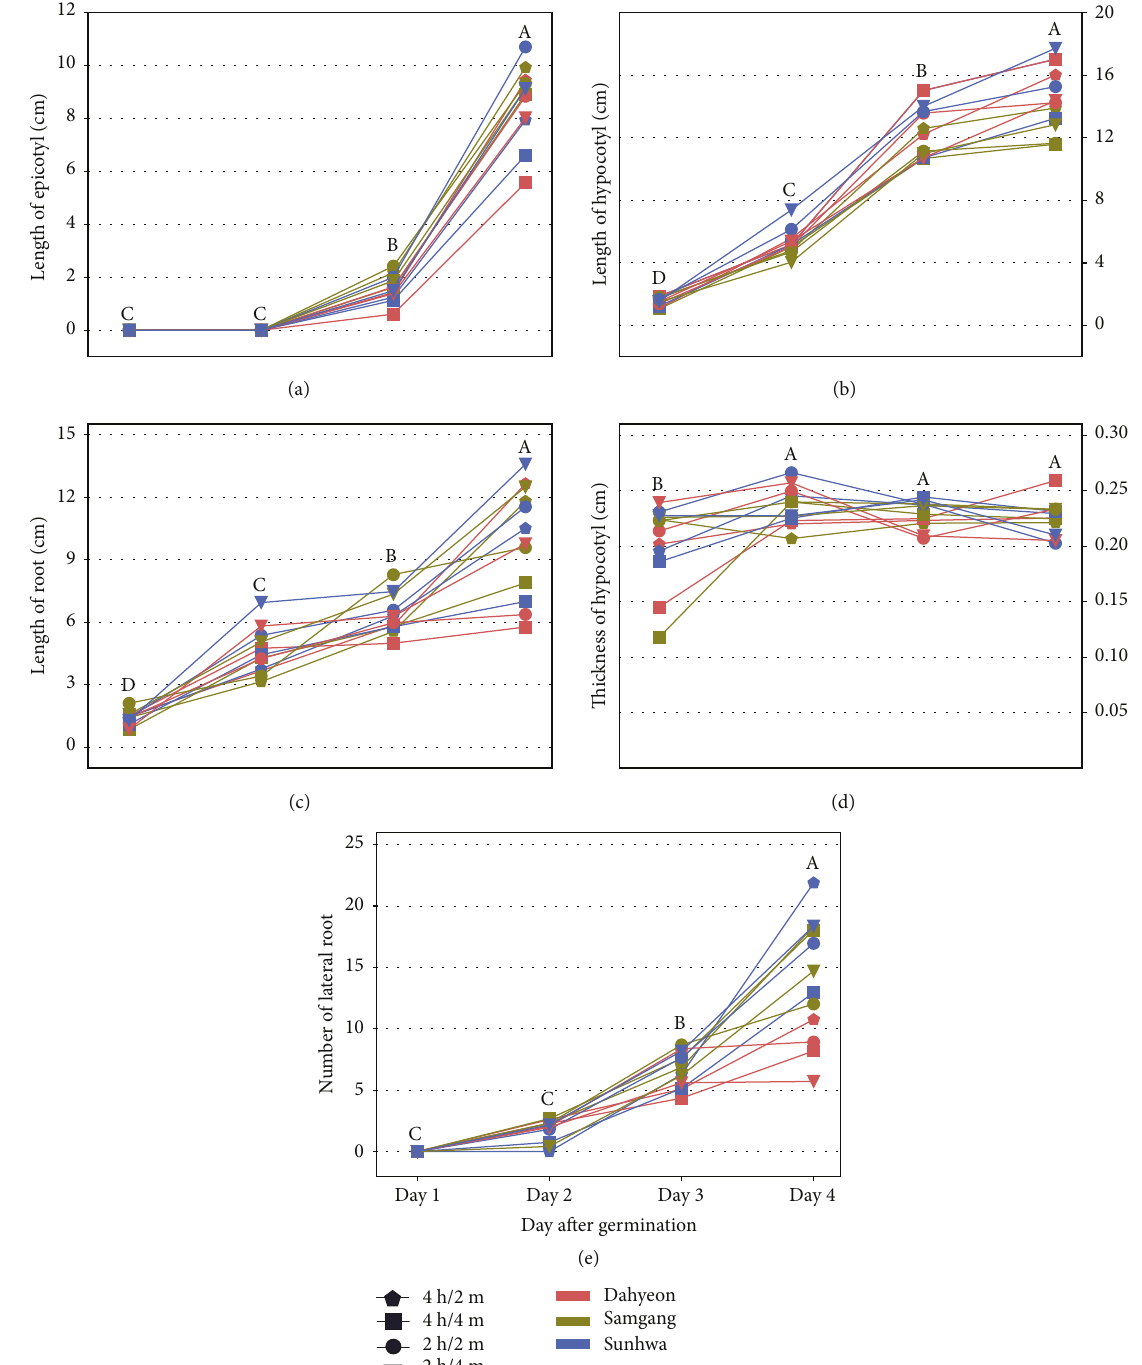
Figure 1: Developments of mung bean sprouts for four days after germination. (a) The length of epicotyl, (b) the length of hypocotyl, (c) the length of root, (d) the thickness of hypocotyl, and (e) the number of the lateral roots. Line color and marker indicate mung bean cultivars and watering conditions, respectively. Results with different uppercase letters indicate statistical significance ( P < 0 .